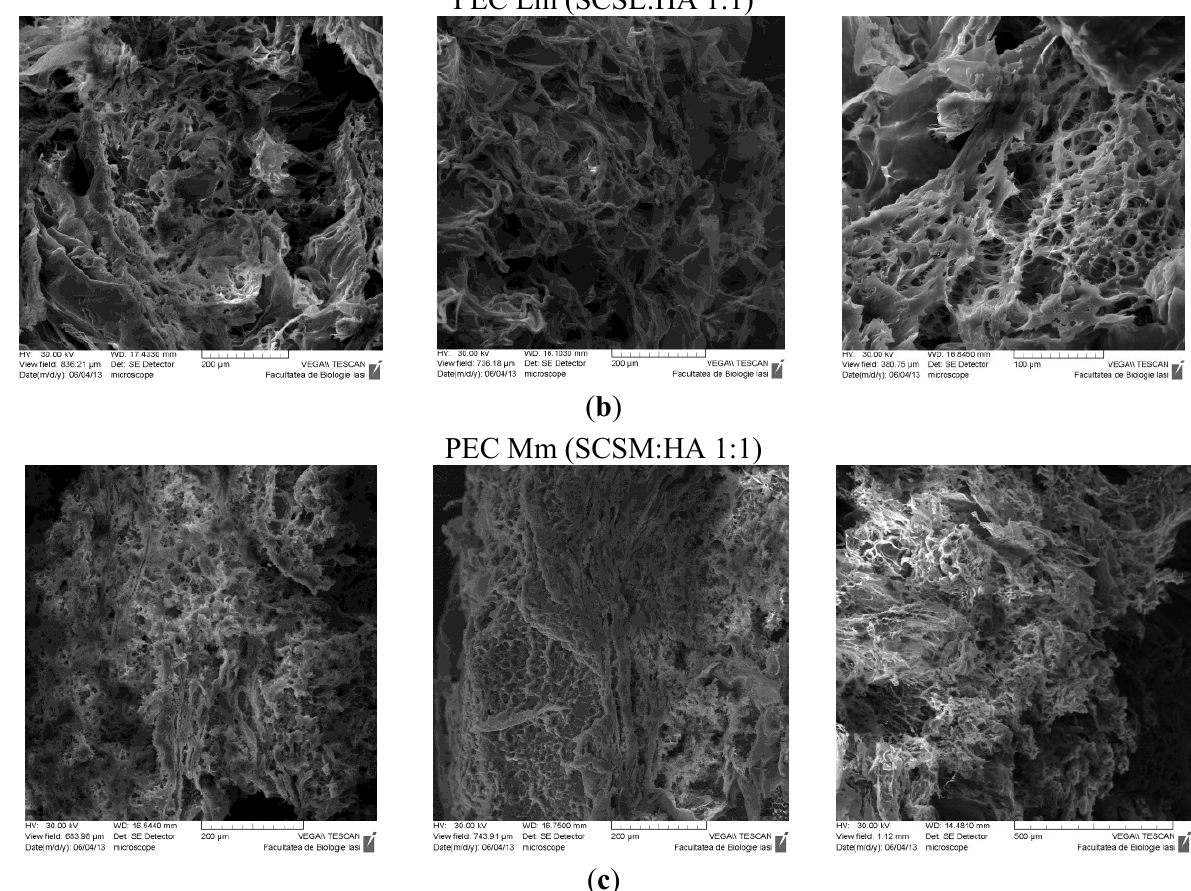
Figure 5. SEM images of PECs (polyelectrolyte complexes): ( a ) PEC L (chitosan low molecular weight-sodium hyaluronate); ( b ) PEC Lm (sulfadiazine modified chitosan low molecular weight-sodium hyaluronate); and ( c ) PEC Mm (sulfadiazine modified chitosan medium molecular weight-sodium